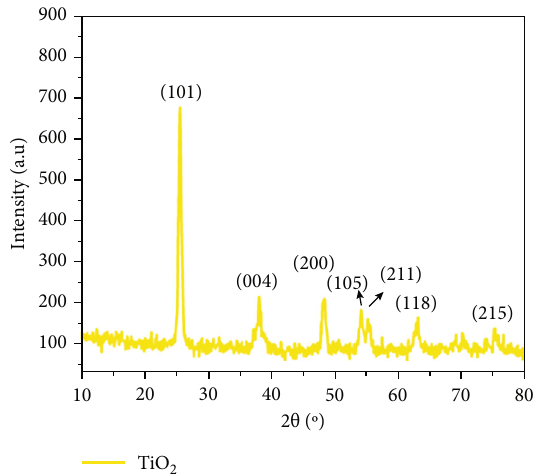
Figure 7: XRD crystalline nature of TiO